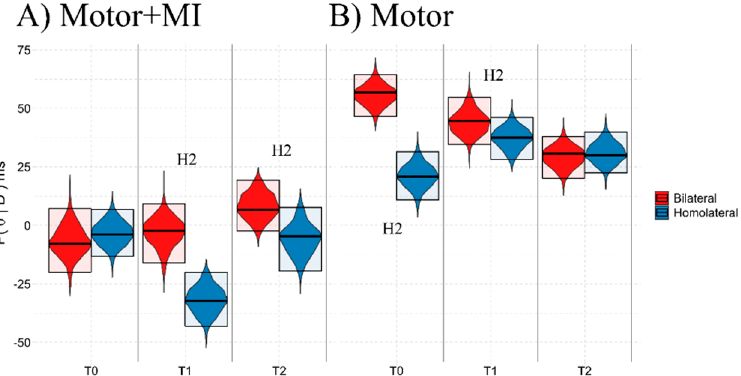
Figure A1. Graphical representation of the marginal posterior distributions of the Space:Condition:Time interaction in the VOID condition. The violin plots represent the marginal posterior distribution of the Bayesian model, the upper and lower boundaries of the box show the limits of the 95% HDI, while the central line represents the distribution mode. On the y-axis, the marginal posterior distribution (P( θ |D)), in milliseconds, represents the performance of the participants, and the x-axis shows the Time points: T0 (pre training), T1 (post training) and T2 (follow-up). ( A ) = Motor + MI, ( B ) = Motor. H1 = Pr(x > 0) > 83.5%, meaning that Homolateral > Bilateral, index of PPS representation. H2 = Pr(x > 0) < 16.5%, meaning that Bilateral > Homolateral, and with no PPS representation.